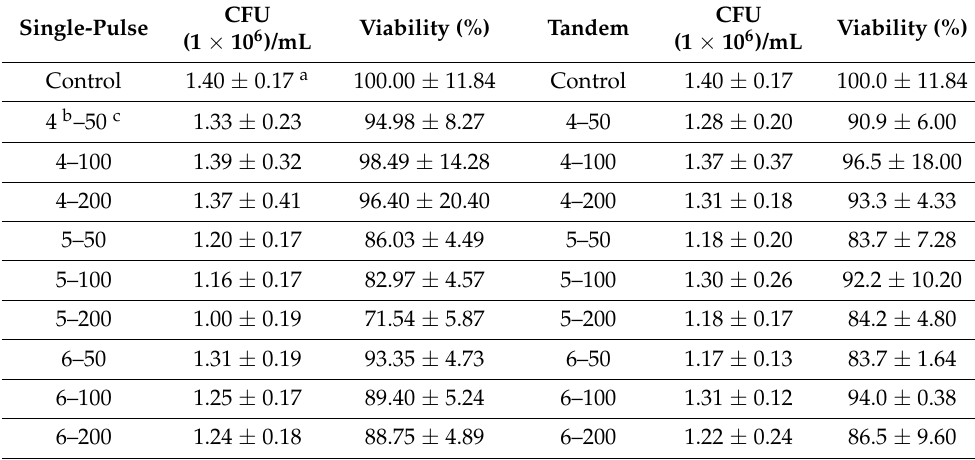
Table 2. Average cell viability values for each group.